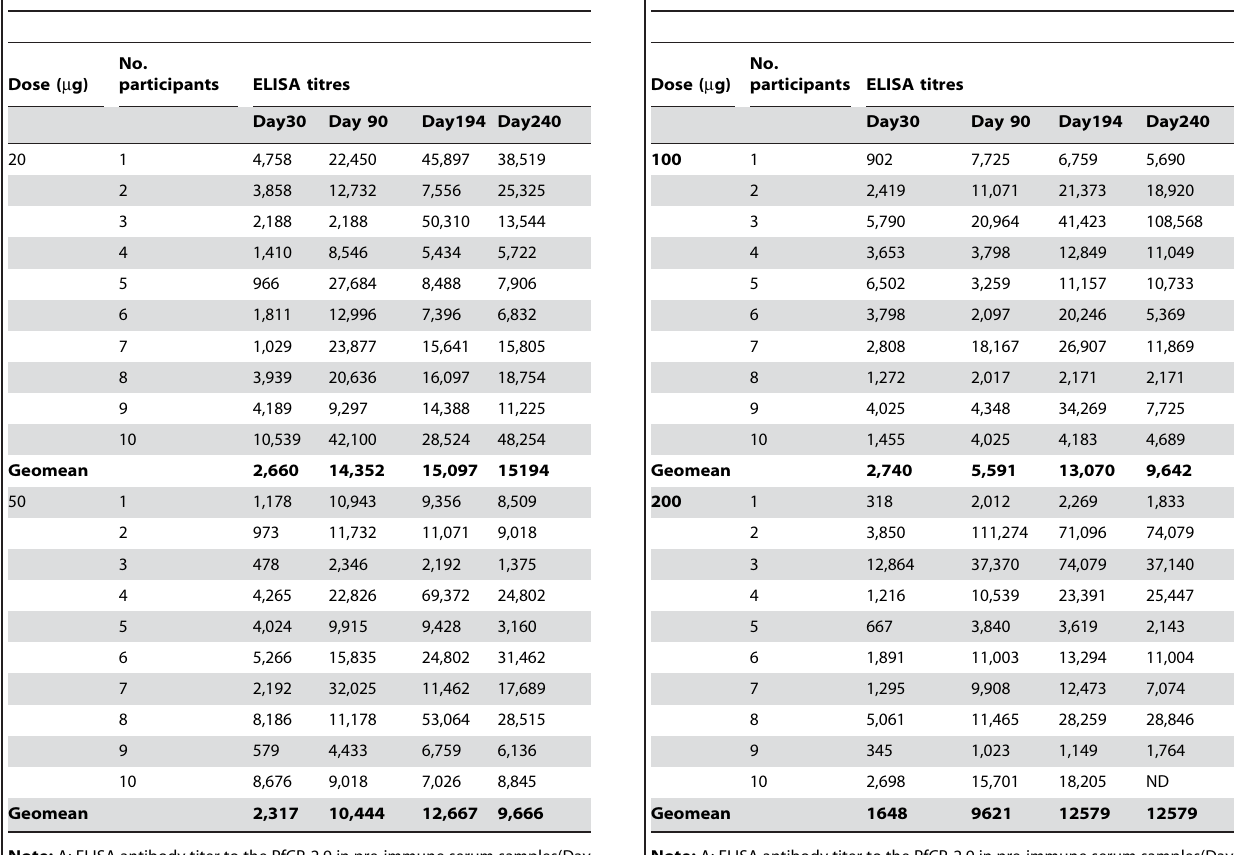
Table 5. ELISA antibody titer in time-point serum samples from participants in 20 and 50 m g groups.